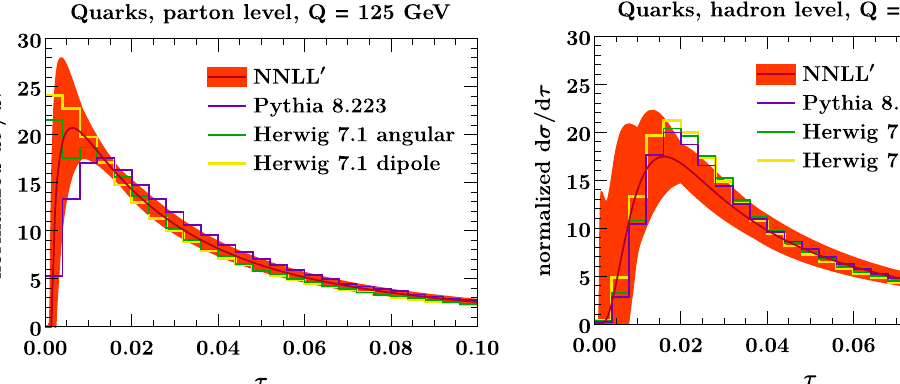
Fig. 3 The normalized thrust spectrum for quarks at NNLL (cid:2) (orange band) compared to Pythia (violet) and Herwig ’s angular-ordered (green) and dipole shower (yellow) at parton level (left panel) and